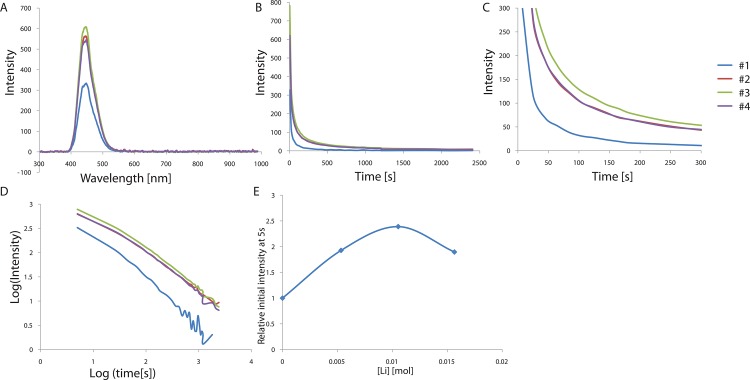
(A) Emission spectrum of CaAl2O4:Eu2+, Nd3+ crystals depending on Li+ concentration. (B) Decay curves depending on Li+ concentration. (C) Magnified views of the graph in (B). (D) Decay curves in log scale depending on Li+ concentration. (E) Relative initial intensity measured at 5s (relative values where the value of control sample #1 is 1.0) depending on Li+ concentration.